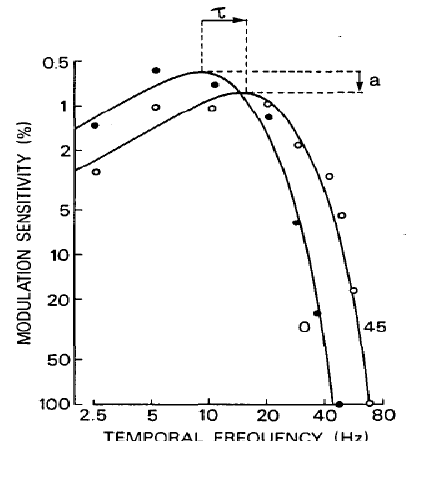
Figure 2. Temporal sensitivity for two different eccentricities (0 and 45 degrees) Reproduced with permission from